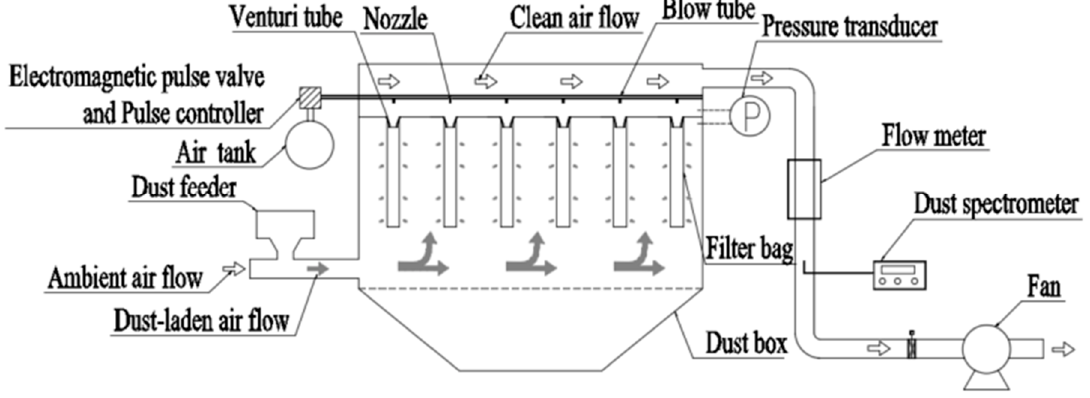
Figure 4. Semi-industrial baghouse experimental device.